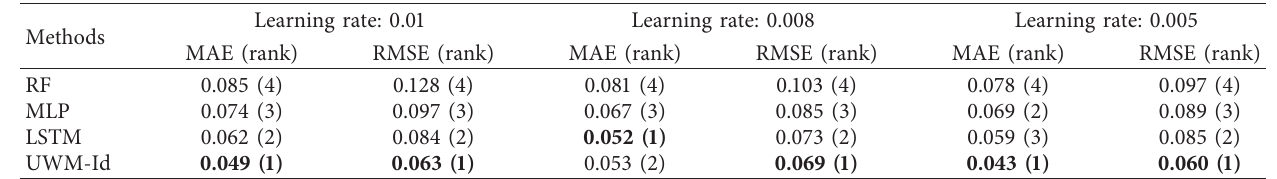
Figure 6: The gray correlation degree of each indicator and water consumption is sorted from large to small. Table 3: Experimental results with the ratio of 6:4 between training set and test set.